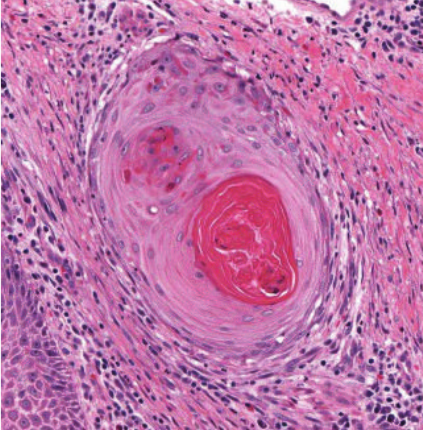
Figure 6: Area extracted from the whole slide image showing desmoplastic response (HE).